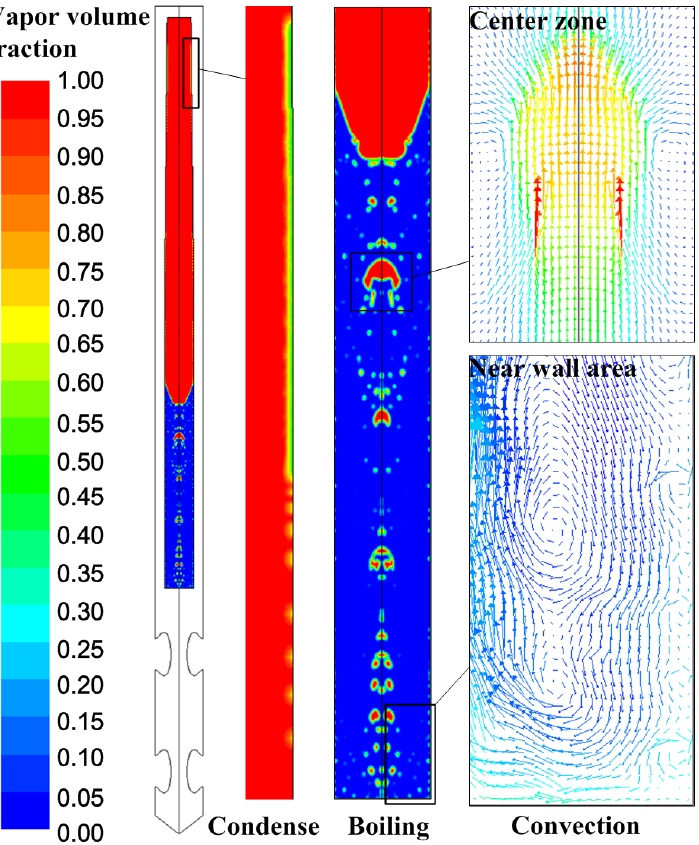
Figure 7. Phase change and fluid flow in the rotating heat pipe.